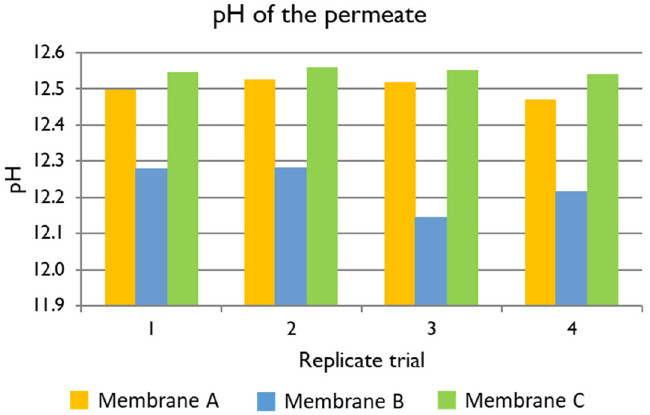
Figure 11. Permeate pH in experiments with black liquor with membranes A, B, and C.